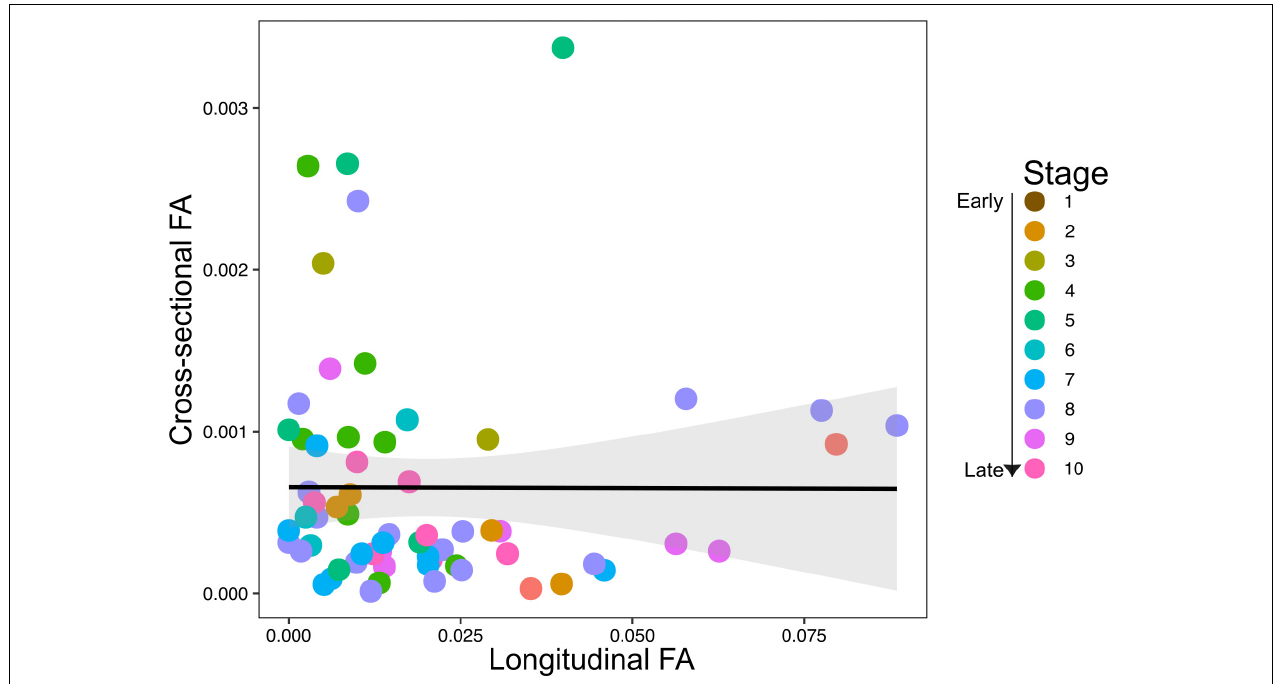
FIGURE 5 | Scatterplot of association between longitudinal (unsigned fluctuating asymmetry, FA) and cross-sectional (unsigned FA) fluctuating asymmetry across prenatal development. Colored dots represent developmental stages, with stages 1–10 representing early to late prenatal